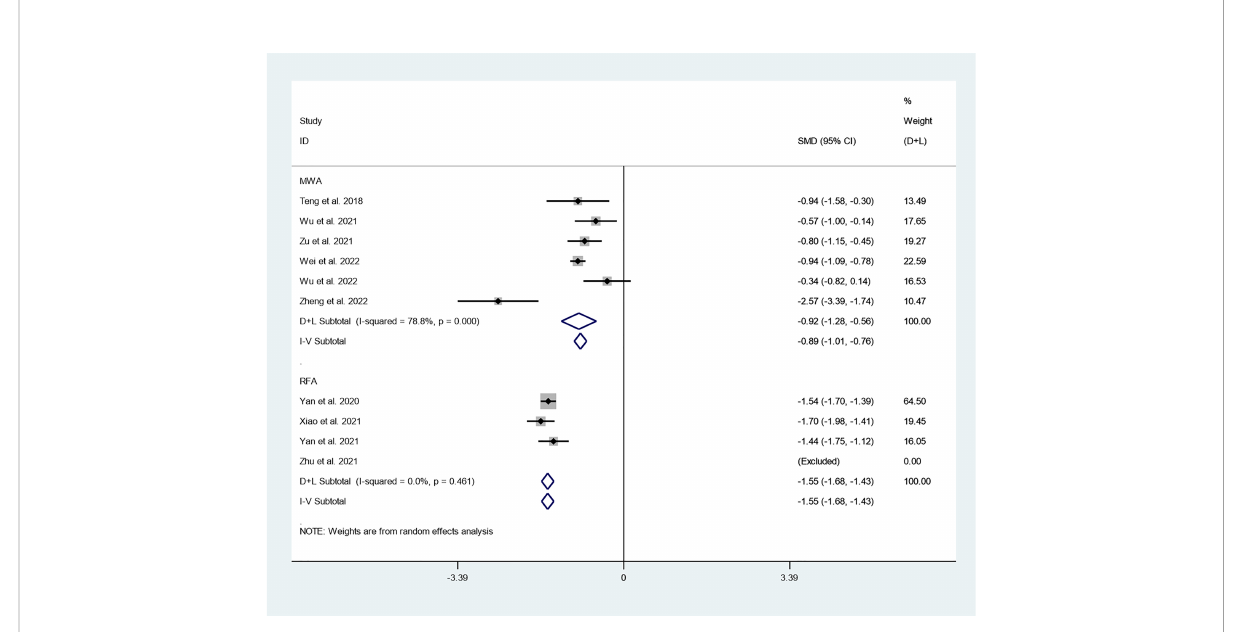
FIGURE 8 Changes in tumor volume after different thermal ablation modalities at 3-year